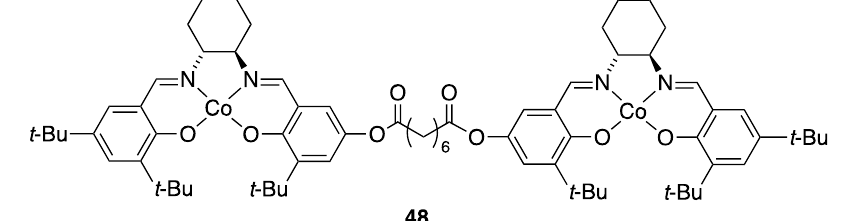
Figure 21. Dimeric Co(II)salen catalyst 48 .